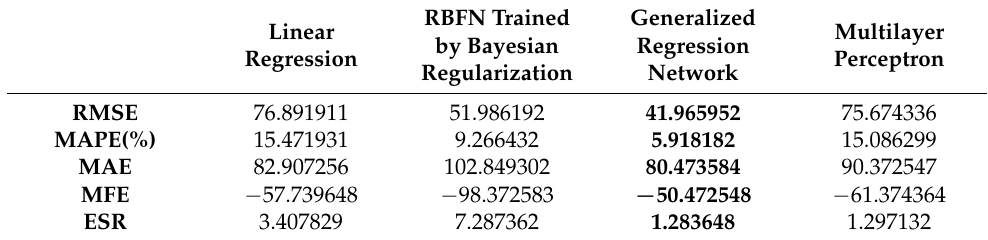
Table 3. ANNs training errors.